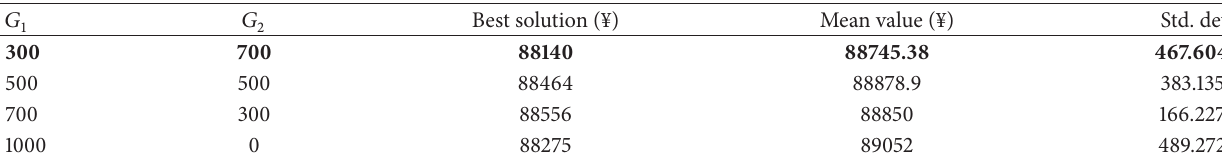
Table 5: Analysis of 𝐺 1 and 𝐺 2 of TSDE.